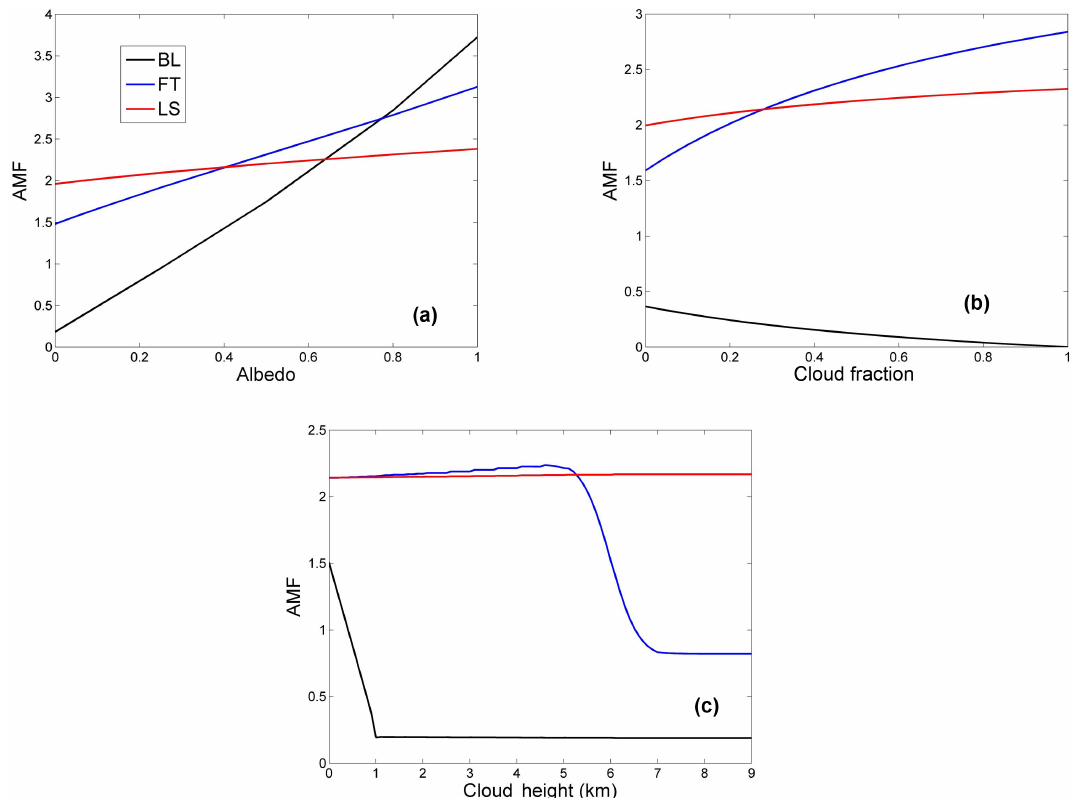
Figure 8. Air mass factors at 313nm for SO 2 in the boundary layer (BL: 0–1km), free troposphere and lower stratosphere (FT, LS: Gaussian profiles with maximum height at 6,15km; FWHM: 1km). Calculations are for SZA = 40 ◦ , Los = 10 ◦ , RAA = 0 ◦ and surface height = 0km. AMFs are displayed as a function of the (a) albedo for clear-sky conditions, (b) cloud fraction for albedo = 0.06, cloud albedo = 0.8 and cloud top height = 2km and (c) cloud top height for albedo = 0.06, cloud albedo = 0.8 and cloud fraction =